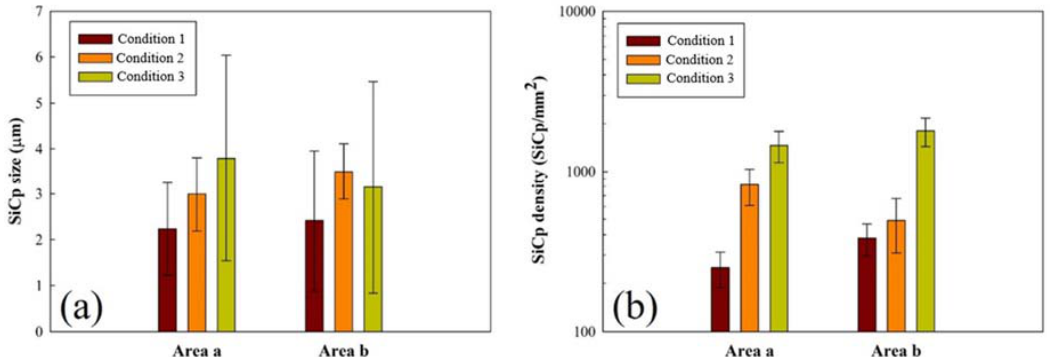
Figure 7. Results on m-SiCp ( a ) size and ( b ) distribution in di ff erent fields and testing conditions.